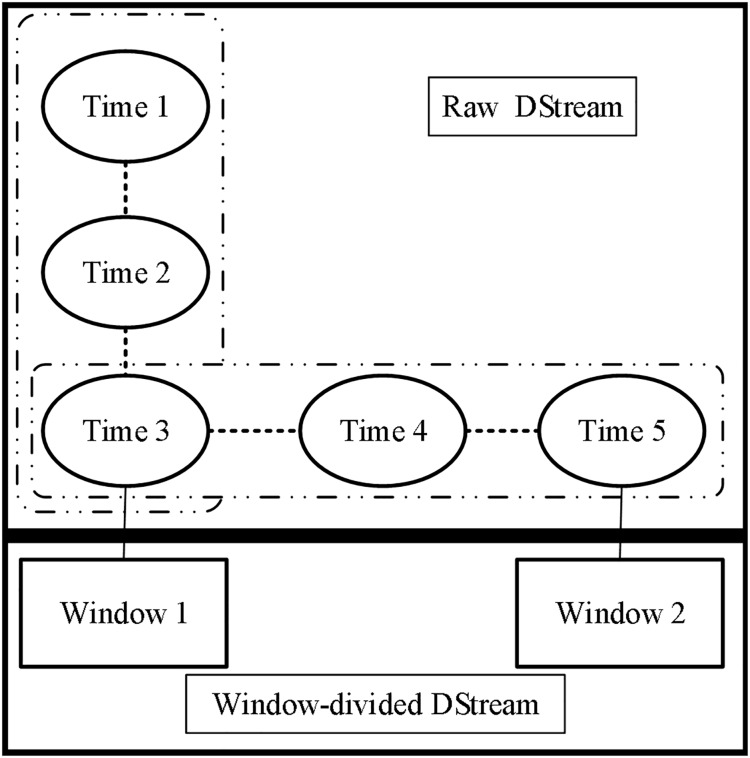
Window sliding mechanism.